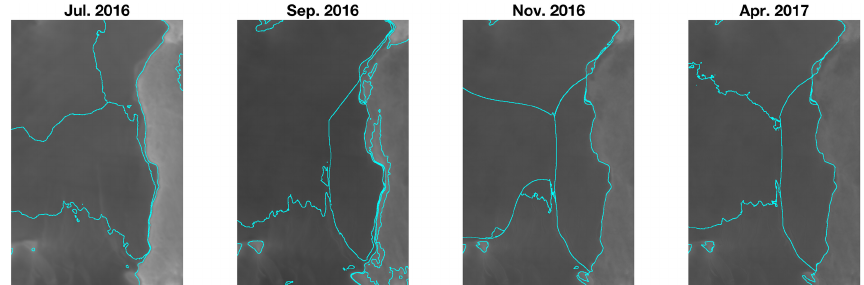
Figure 7. Complementing Fig. 6, this figure shows the DAS boundaries (right) for different time windows, starting from July 2016 to April 2017. Raw images sourced from Scambos et al.